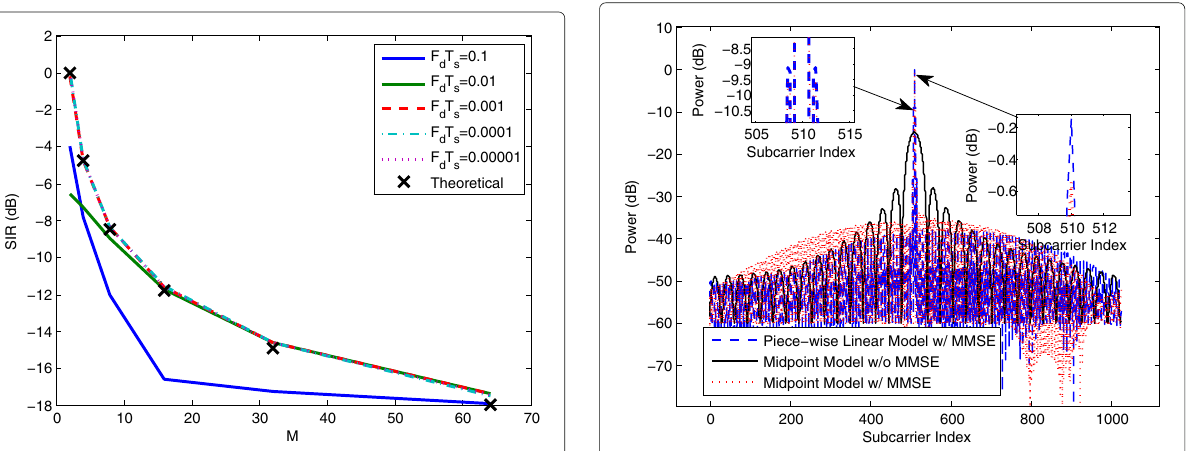
Fig. 3 The pre-equalized SIR of multi-segment OFDM signals with exponential power delay profile and different normalized Doppler frequencies, N s = 512, L = 3